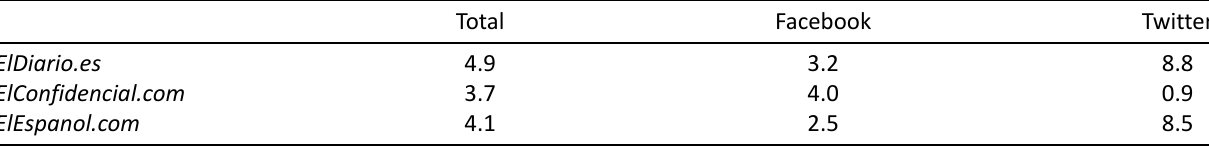
Table 7. Presence of incivility, profanity and derogatory remarks (%).